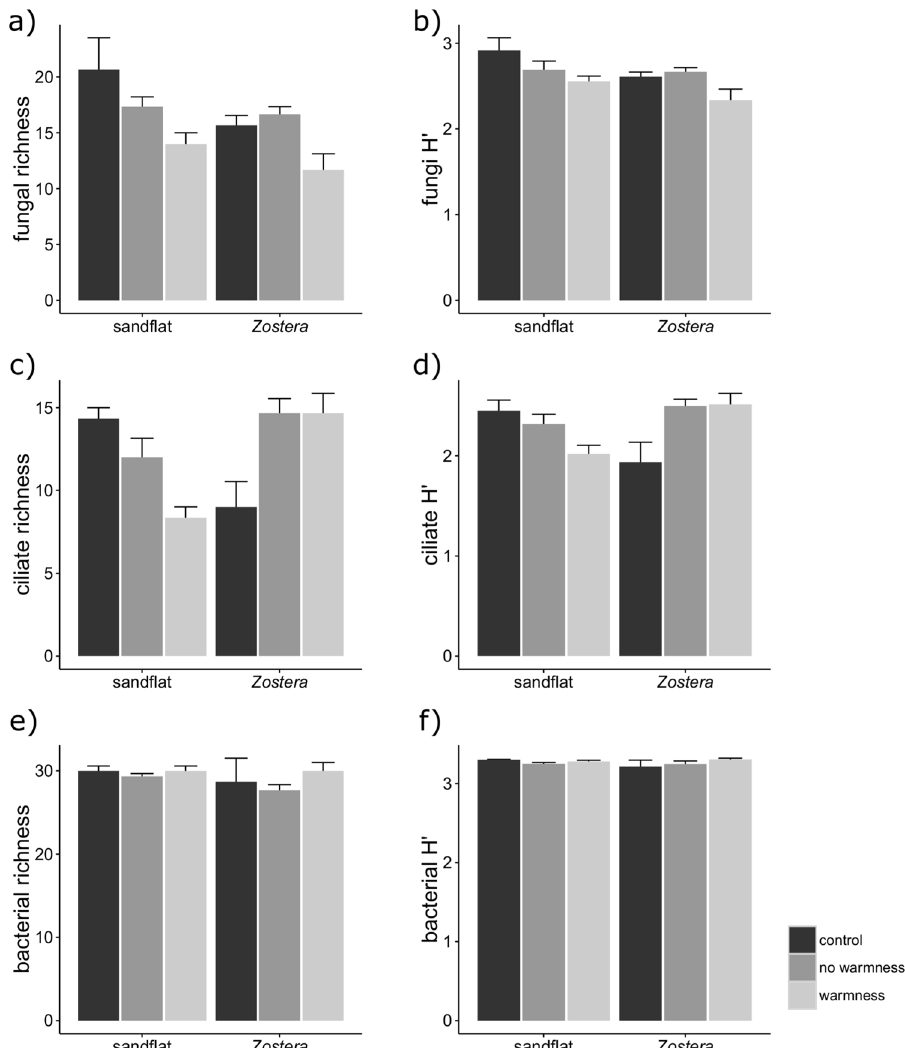
Figure 3. Mean + s.d. (n = 3) richness of fungal ( a ), ciliates ( c ) and bacterial ( e ) communities and Shannon- Wiener index of fungal ( b ), ciliates ( d ) and bacterial ( f ) communities on sediment samples from sandflat or Zostera under control, no warmness and warmness